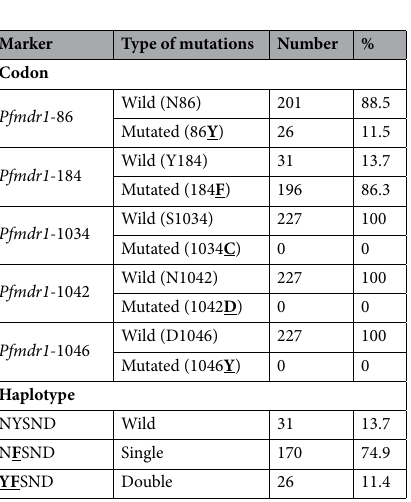
Figure 1. A map of the study area in Jazan region, southwestern Saudi Arabia (12 governorates were involved in this study). The map was originally generated using ArcGIS software version 10.8.1.